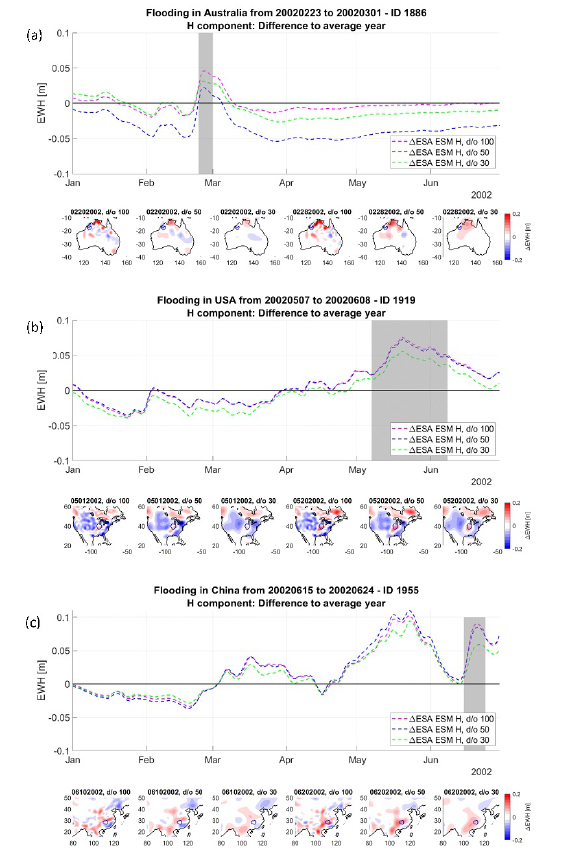
Fig. 4. Comparison of the H (green), HIS (cyan) and AOHIS (red) com- ponent of the ESA ESM for the chosen areas of interest. The vari- ability of the whole AOHIS signal due to the atmosphere is clearly visible. The HIS signal is enhanced in the example of Australia (a), while in the example of the US (b) and China (c) it is dampened. The duration of the flood is indicated in grey. Below each time series graph, a spatial plot of the area for the H, AOHIS and HIS compo- nent is shown at a time within the